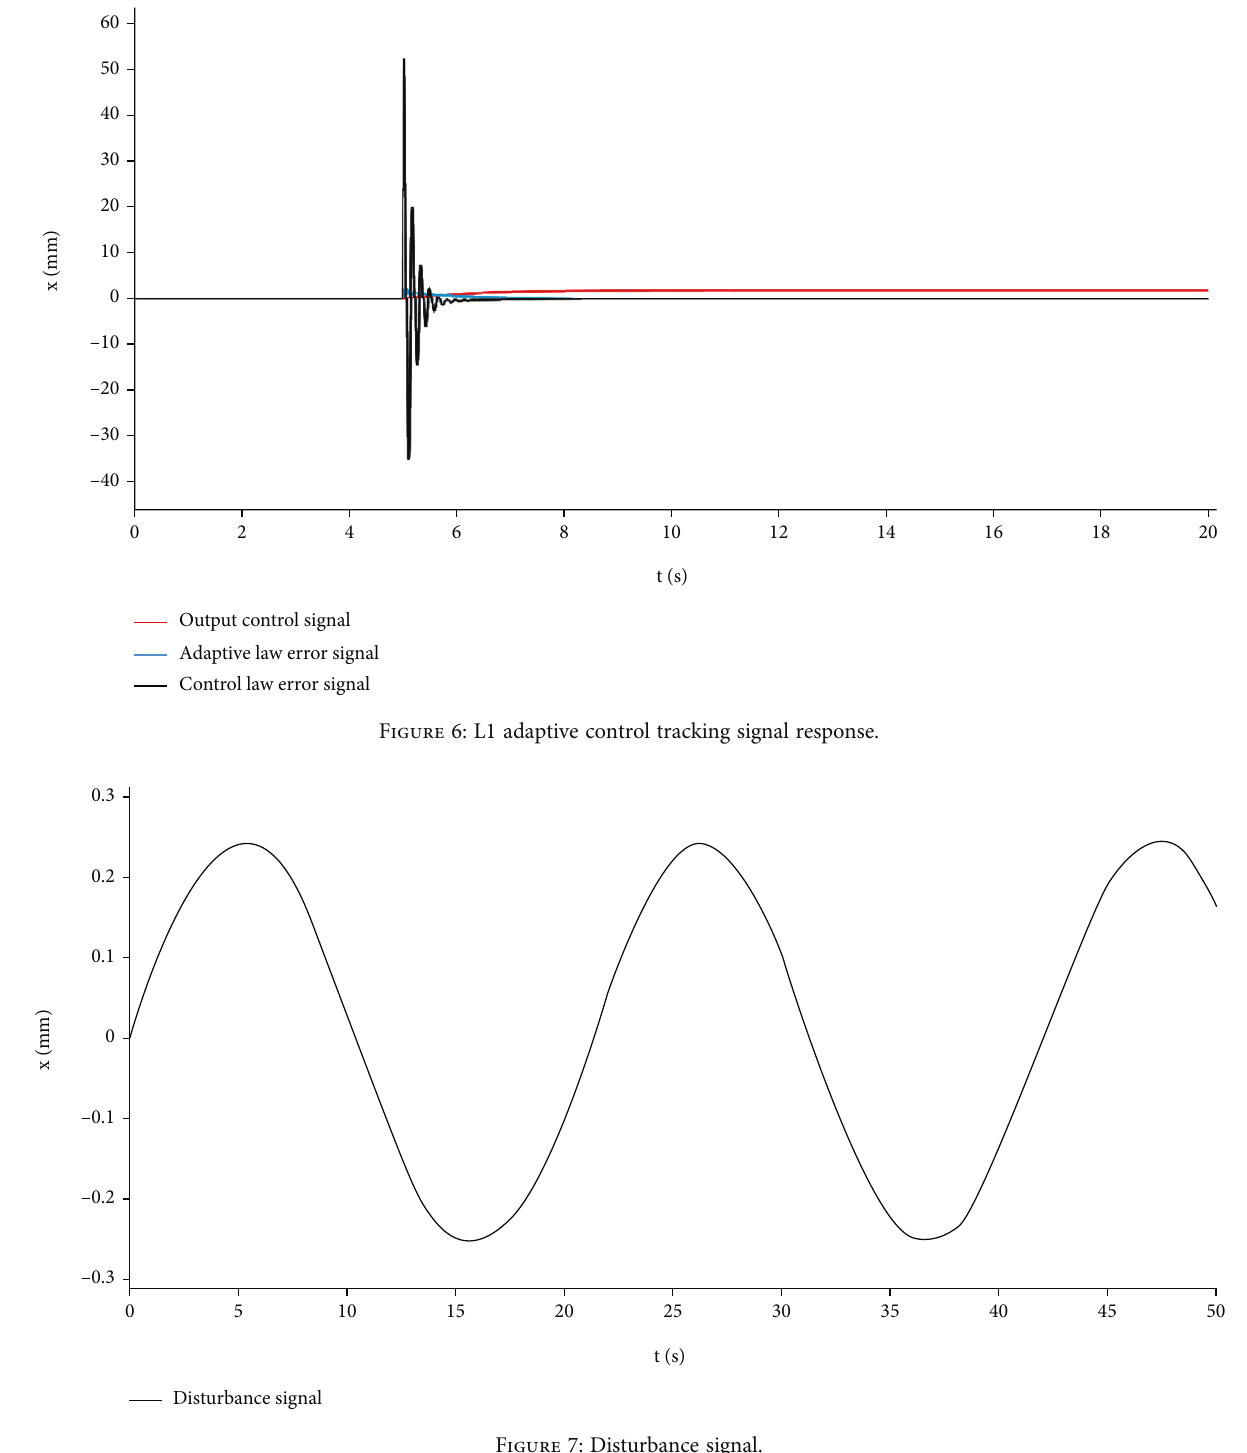
Figure 7: Disturbance